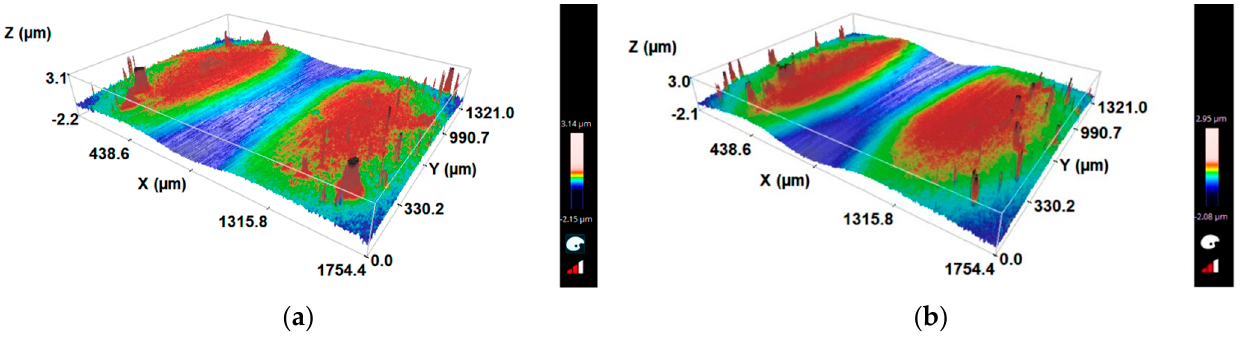
Figure 17. Topography of the ball tracks analyzed by 3D profilometry for: ( a ) slurry concentration (SC) 0.25 g/cm 3 and load 0.2 N and ( b ) (SC) 0.45 g/cm 3 and load 0.2 N. Note that the xx axis in the figures are different, thus the track of ( a ) is wider than ( b ).